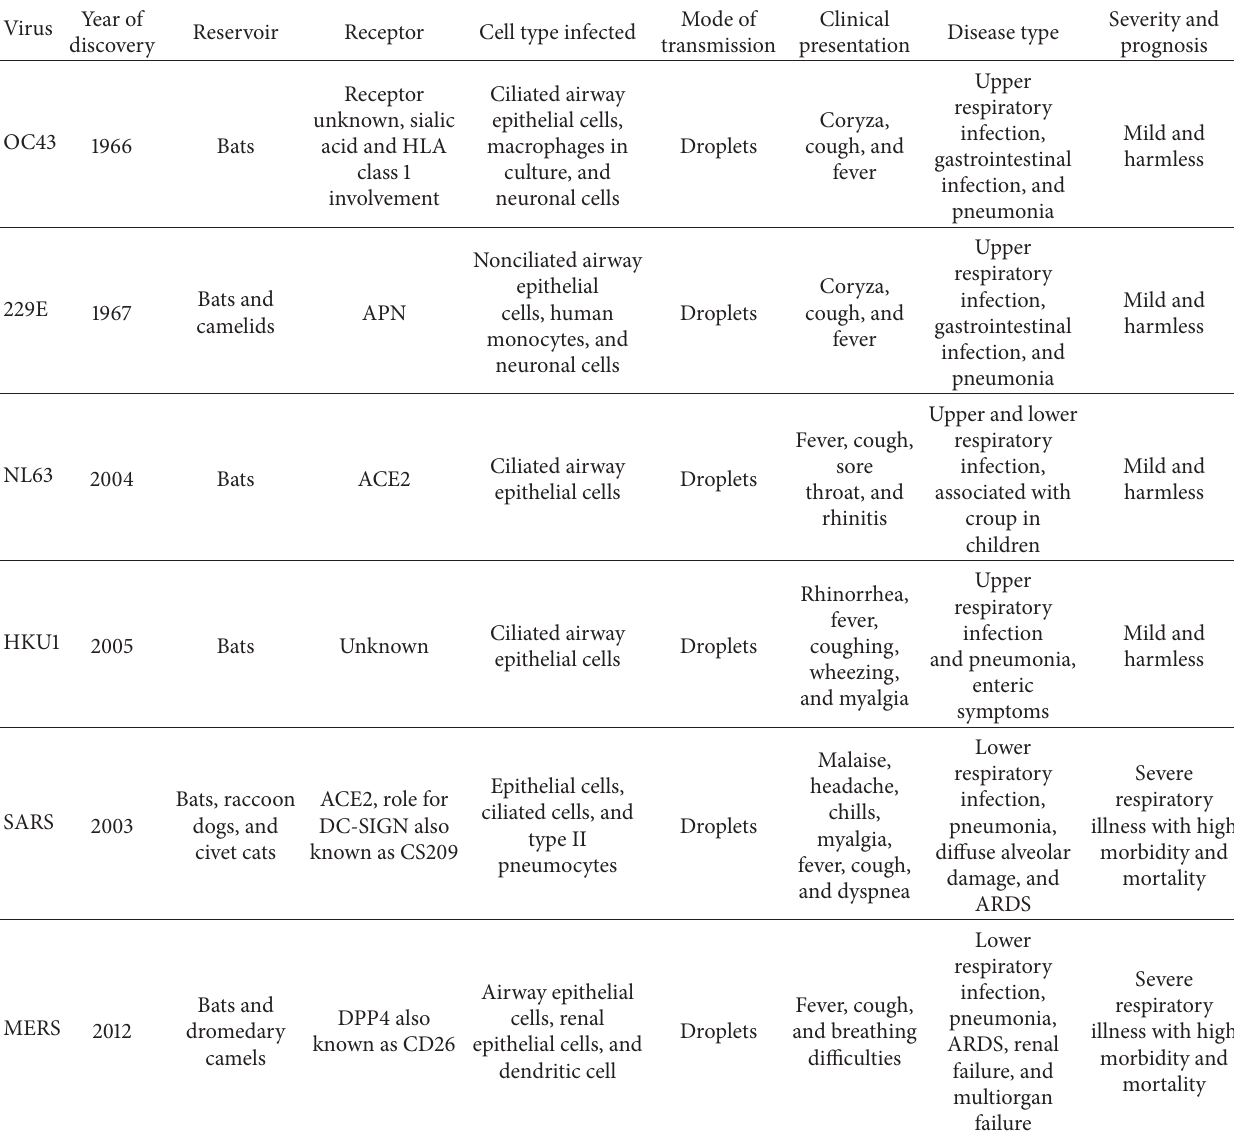
Table 1: The human corona viruses